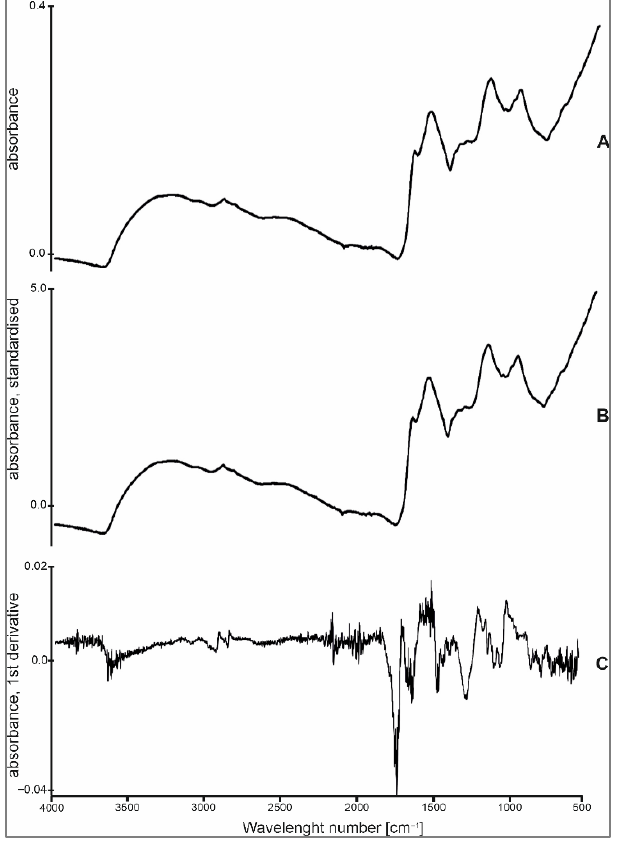
Figure 2. Mid-infrared absorbance spectra ( A )—without processing, ( B )—after standardization (SNV), ( C )—after SNV and 1st derivative. Table 1. Soil location, land use and classification.